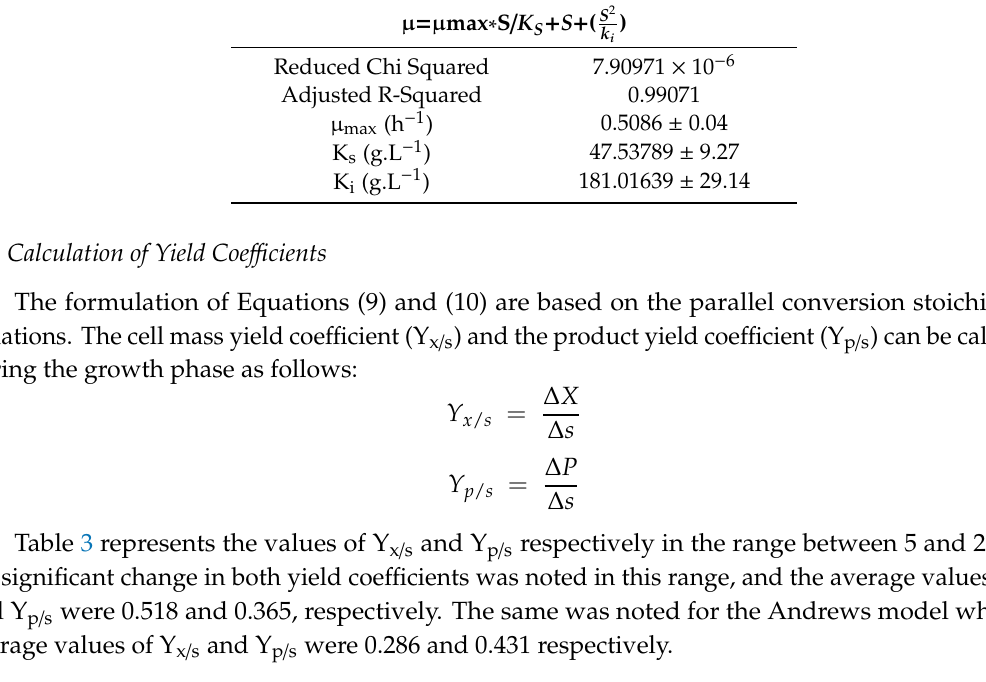
Table 3. The variation of the yield coe ffi cients at di ff erent initial substrate concentrations for the Monod